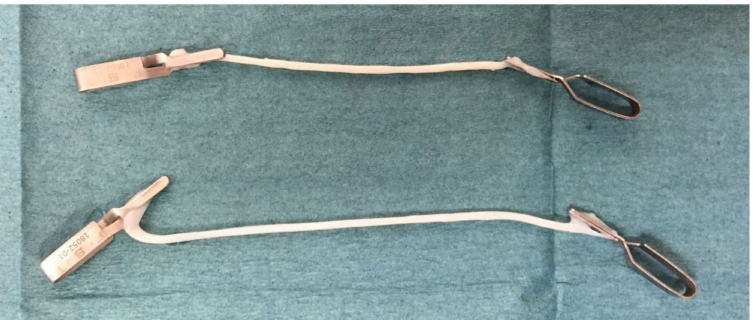
Figure 4. Tendon like constructs after 21 days of mechanical stressing using the bioreactor. The top one contains spider silk (experimental group A), the bottom one is manufactured without spider silk (experimental group B). The constructs showed phenotypes comparable to tendon tissue with no difference between experimental groups A and